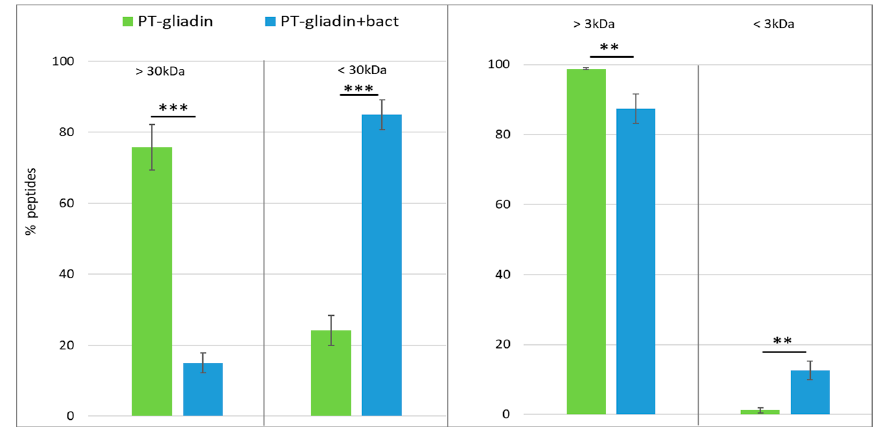
Figure 2. Molecular fractionation of digested gliadin. PT-gliadin and PT-gliadin + bact were sequentially filtered onto membrane filters of 30 and 3 kDa and the amount of peptides assessed by ELISA. ** p < 0.01; *** p < 0.001.